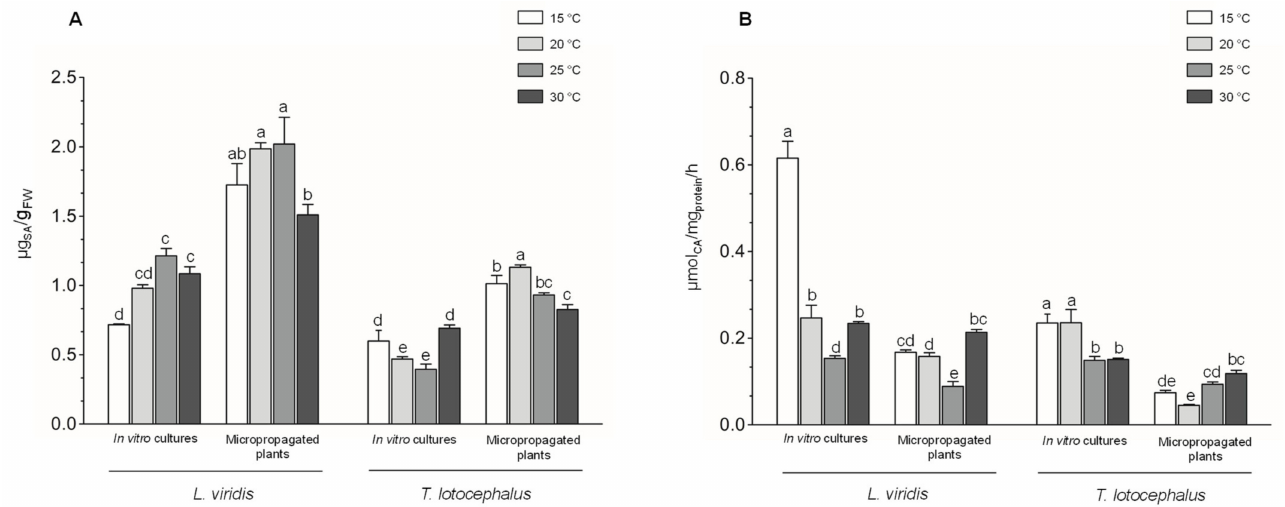
Figure 1. Effect of exposure to different temperatures (15, 20, 25, and 30 ◦ C) on secondary metabolism keys—( A ) shikimic acid content and ( B ) phenylalanine ammonia lyase (PAL) activity—of in vitro cultures and micropropagated plants of Lavandula viridis and Thymus lotocephalus . For each